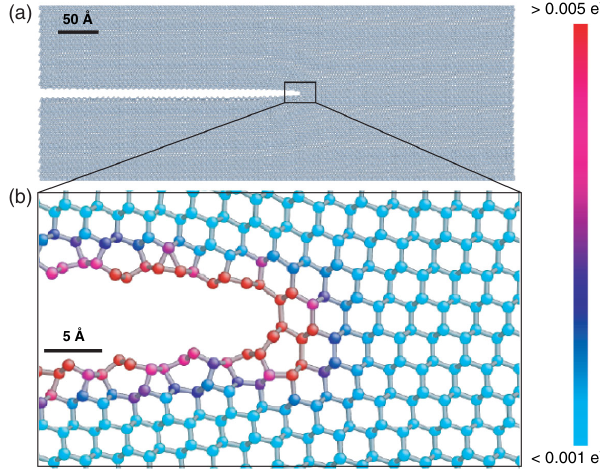
FIG. 15. (a) Snapshot from a quasistatic simulation of fracture 1¯10 (cid:3) in the Si ð 111 Þ½ cleavage system at a strain energy release rate of G ¼ 5 . 13 J = m 2 . The model system contains 23 496 atoms and has dimensions 600 × 200 × 3 . 86 Å 3 . (b) A close-up of the crack tip, which undergoes a crack-tip reconstruction as previously reported in DFT-based hybrid simulations in Ref. [204]. Atoms are colored by the predicted error per atom of the GAP model, from blue (low) to red